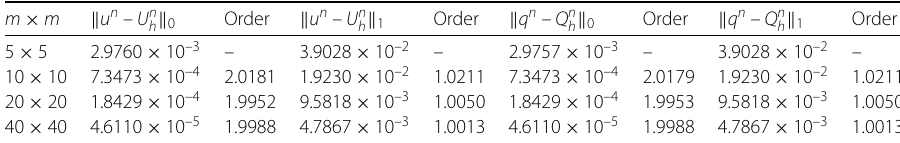
and Q n when t = 0.25 ( τ = 5 h 2 ) h h